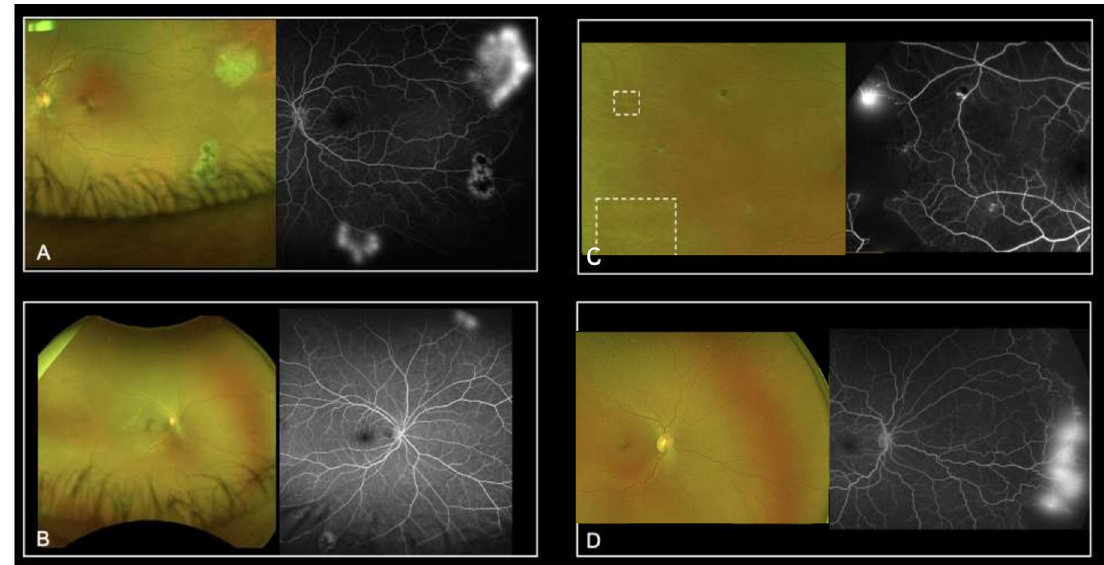
Figure 2. Representative UWF ‐ imaging where neovascularization was not detected on the UWF ‐ FP: sea fan lesion was masked by eyelids ( A ), it was out of the field of view and revealed by leakage on the late frames of UWF ‐ FA ( B ) or resolution was insufficient ( C , D ).